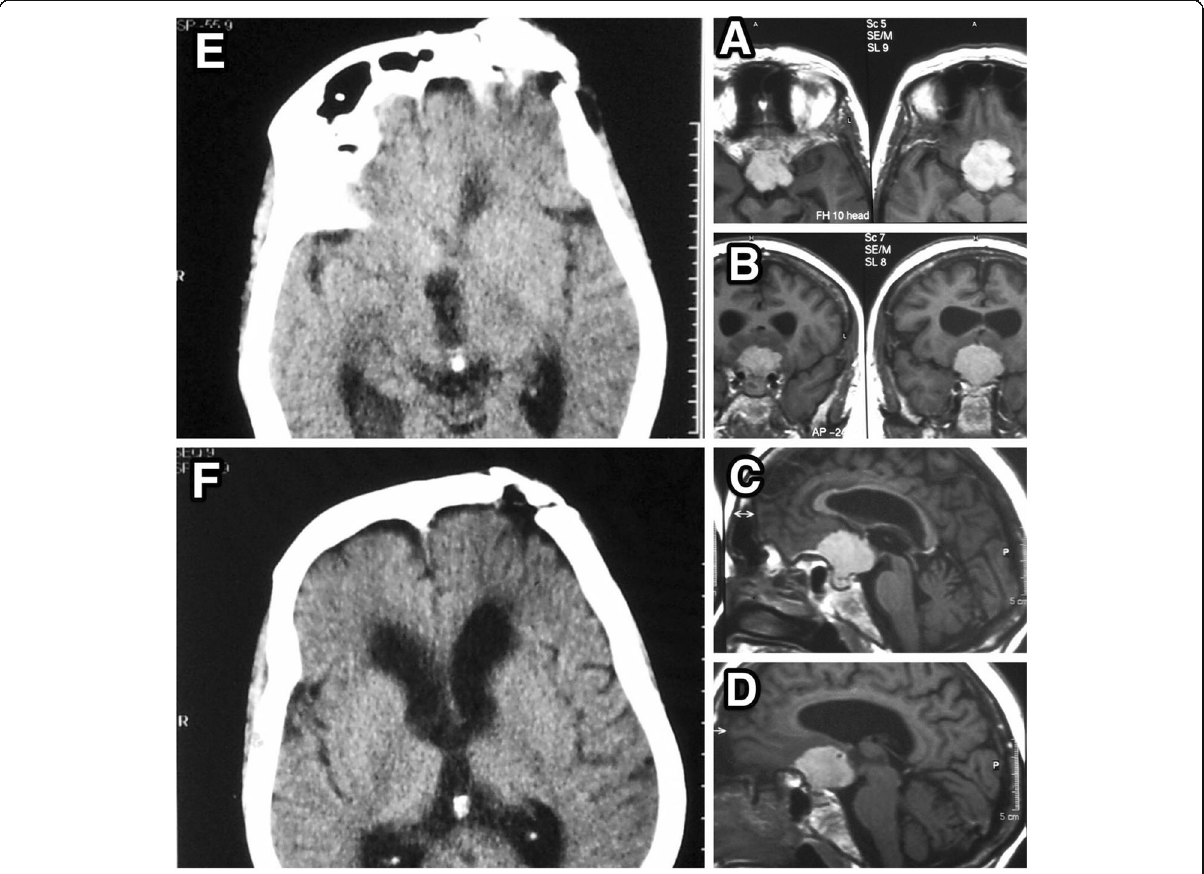
Fig. 1 Suprasellar meningioma operated through left subfrontal approach (side of more affected optic nerve) in supine position. A - D Preoperative MRI. E , F Postoperative CT